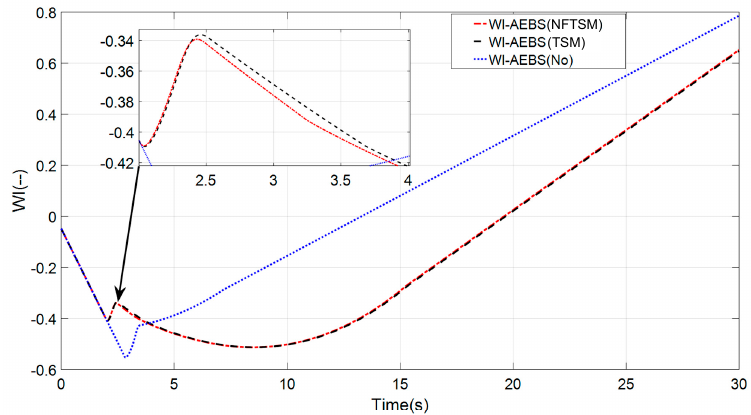
Figure 20. Comparison of relative